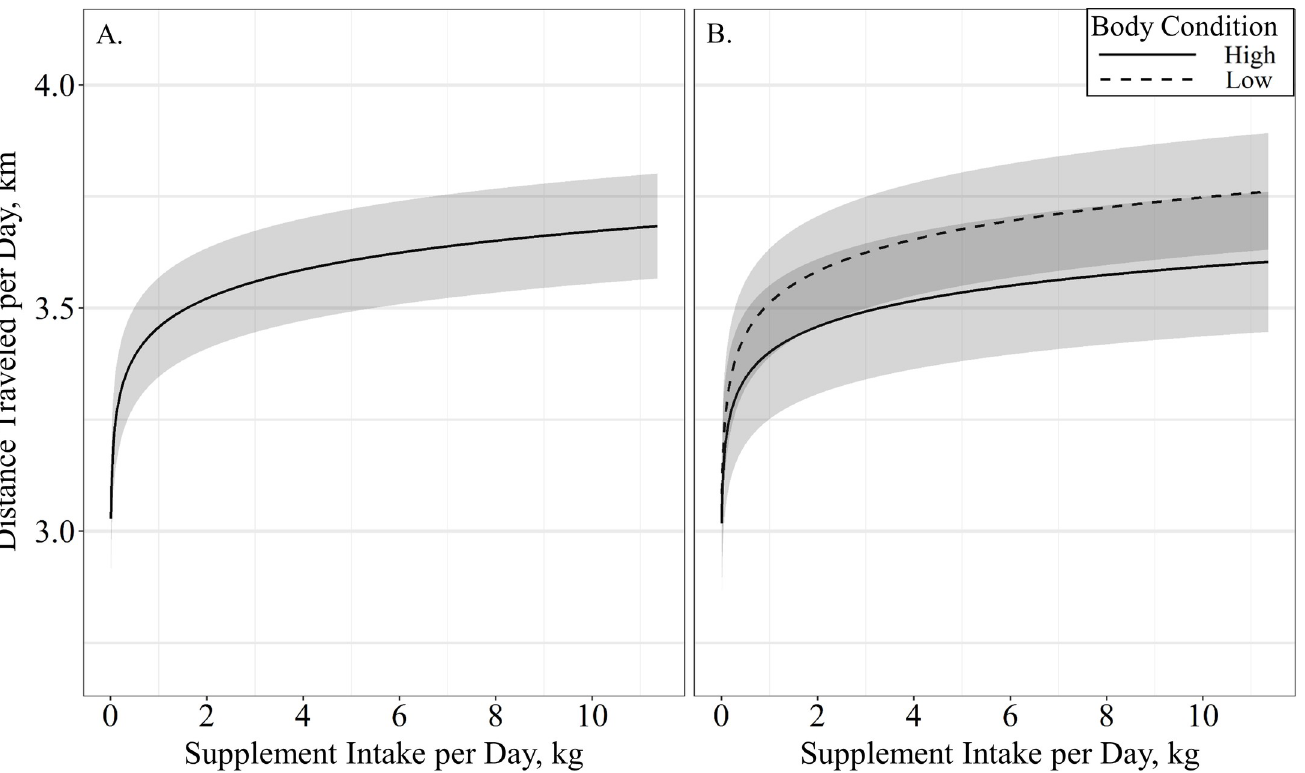
Fig 2. Predicted relationships ( ± 95%CI represented in the shaded area) between ( A ) average supplement intake per day (kg) and ( B ) the interaction of average supplement intake per day by body condition on distance traveled per day (km) by cattle grazing dormant northern mixed grass rangeland in 2016 – 2017 & 2017 – 2018 at the Northern Agricultural Research Center Thackeray ranch, Havre,